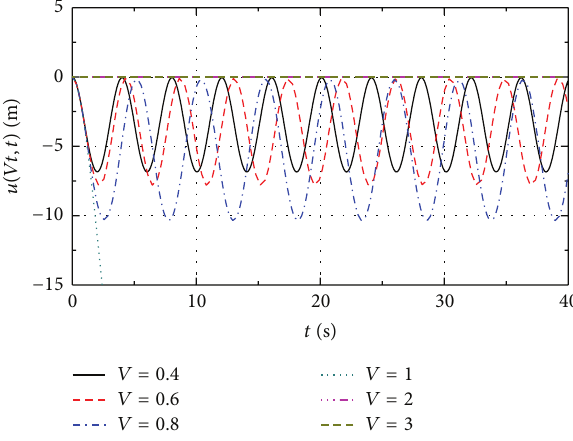
Figure 4: The contact force between the mass and the string.